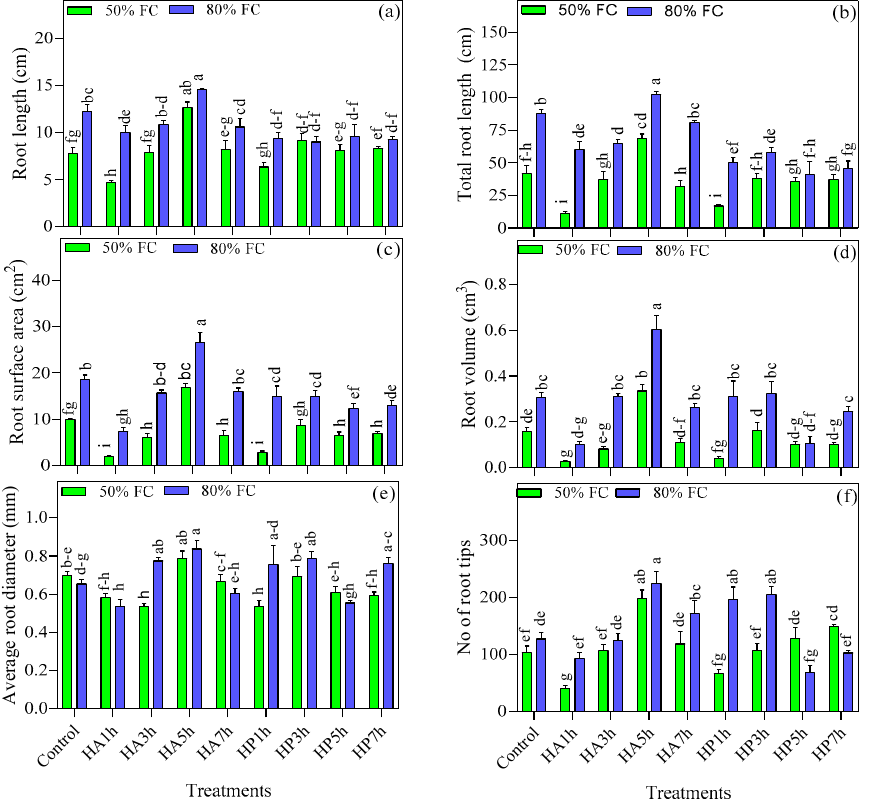
Figure 5. Interaction effect of priming treatments and field moisture level on ( a ) root length (RL); ( b ) total root length (TRL); ( c ) root surface area (RSA); ( d ) root volume (RV); ( e ) average root diameter (ARD) and ( f ) number of root tips (NORT) and means ( ± SE) followed by the same letters do not differ significantly between treatments x field moisture level using Ls means at p < 0.05.